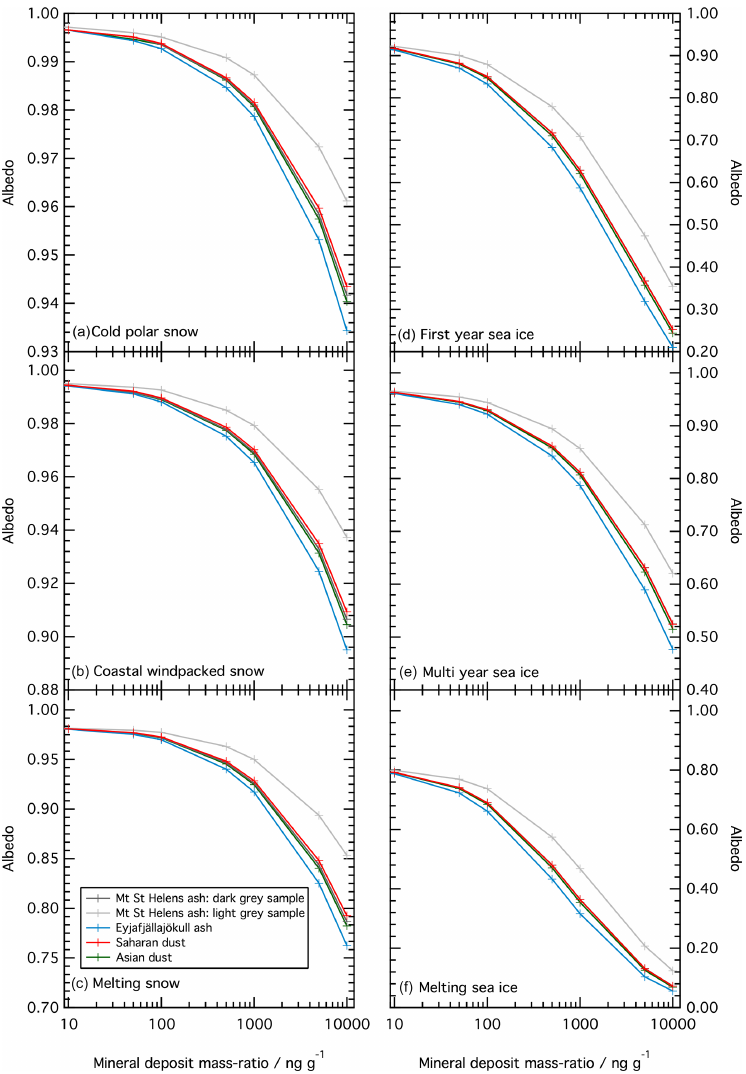
Figure 5. Albedo of three semi-infinite snow and sea ice types with increasing mineral aerosol deposits mass ratio at 450nm. The y axis has different scales in each section to cover the large range of